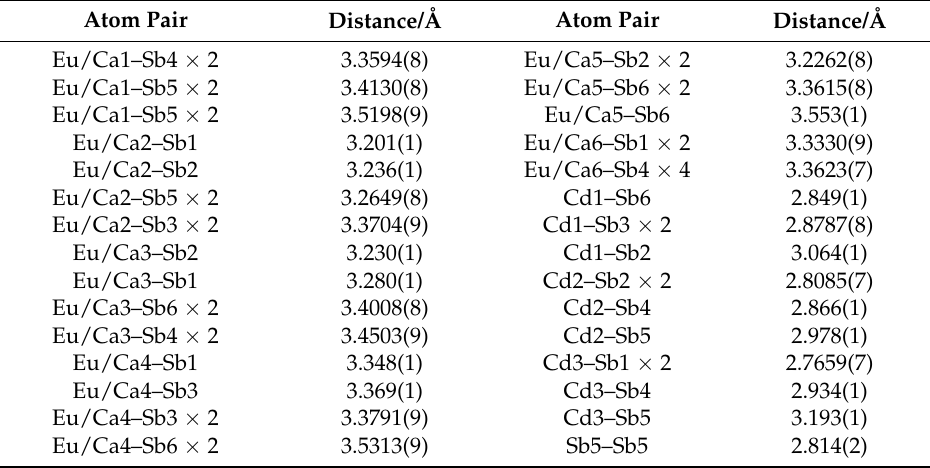
Table 8. Selected interatomic distances for Eu 11 − x Ca x Cd 6 Sb 12 , x = 0.99(1).